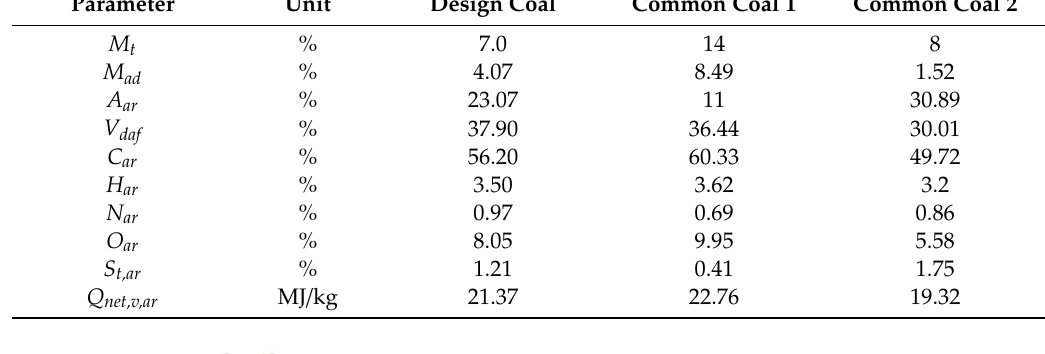
Table 1. Common coal quality of boiler.